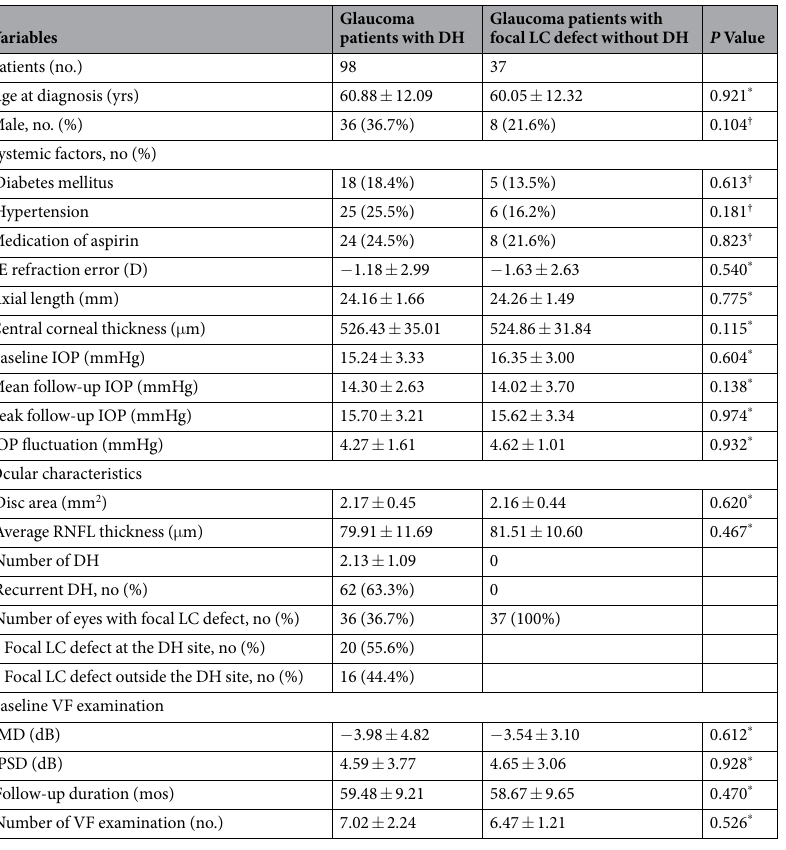
Table 1. Demographics and clinical characteristics of glaucoma patients with disc hemorrhage. D, diopters; IOP, intraocular pressure; RNFL, retinal nerve fiber layer; DH, disc hemorrhage; LC, lamina cribrosa; MD, mean deviation; PSD, pattern standard deviation; VF, visual field. Data are mean ± standard deviation unless otherwise indicated. * Student t-test. † Chi-square test. Data are mean ± standard deviation unless otherwise